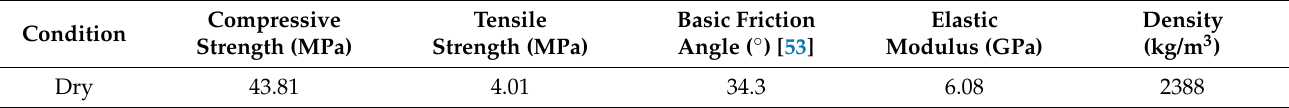
Table 2. Basic mechanical parameters of red